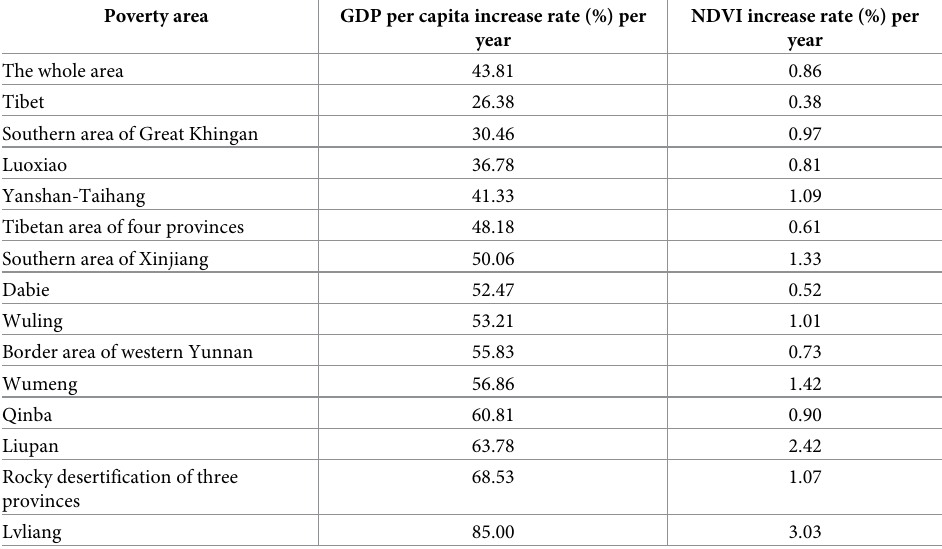
Table 2. The change differences and correlations between GDP and NDVI in the fourteen contiguous areas of dire poverty. Poverty area